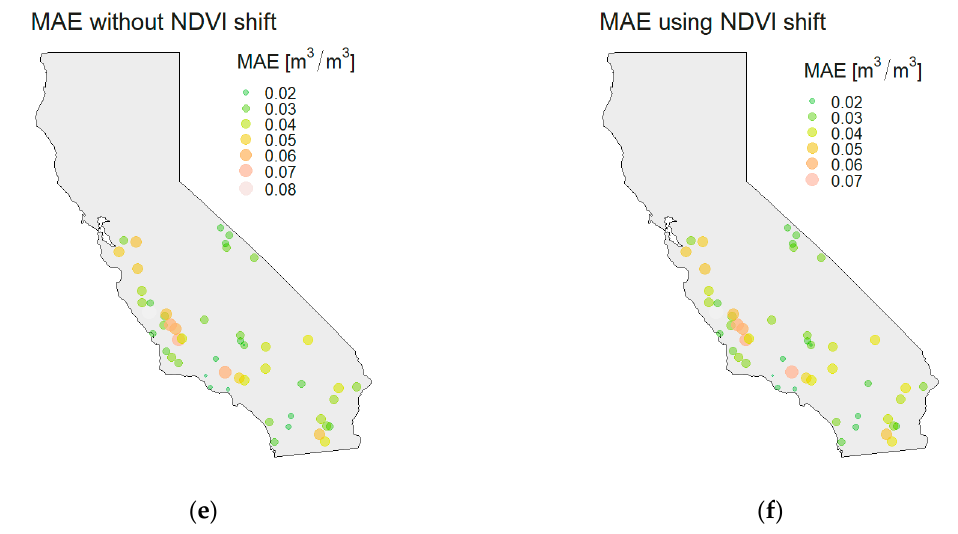
Figure 9. Spatial distribution of the calculated metrics presented by bubble plots without and with using NDVI shift: (a,b) RMSE; (c,d) R 2 ; and (e,f) MAE.